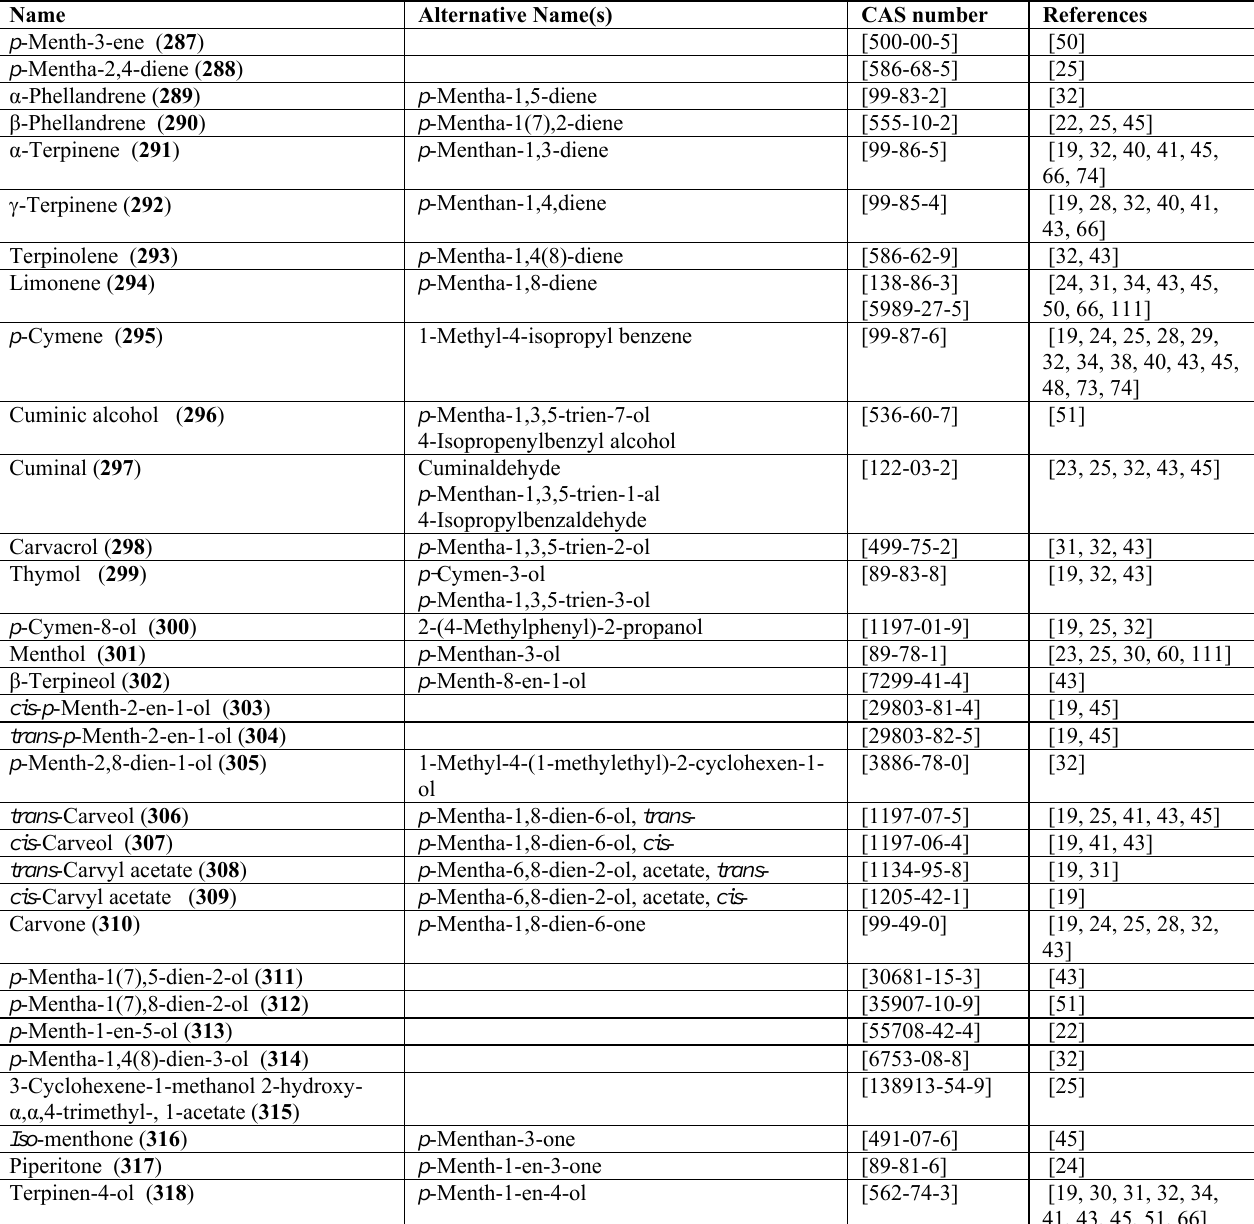
Table 25. p- Menthane Monoterpenoids, 8CI (1-Methyl-4-(1-methylethyl)cyclohexane,